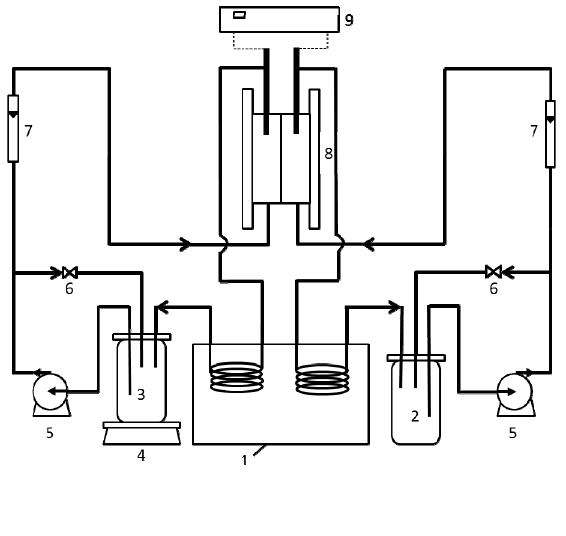
Figure 7. Schematic diagram of FO setup: (1) water bath; (2) draw solution; (3) feed solution; (4) electronic balance; (5) diaphragm pump; (6) valve; (7) flow meter; (8) membrane module; (9)